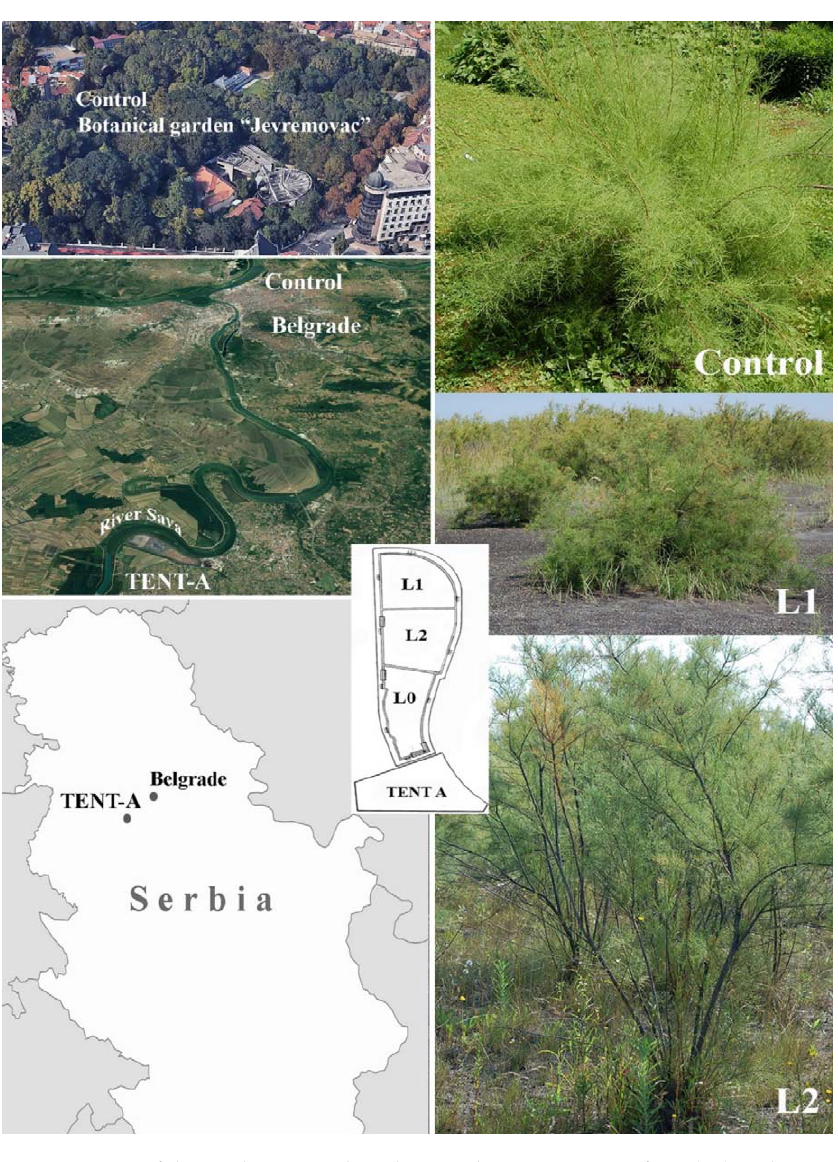
Figure 1. Map of the study area and study sites: lagoons inactive for 3 (L1) and 11 years (L2), active